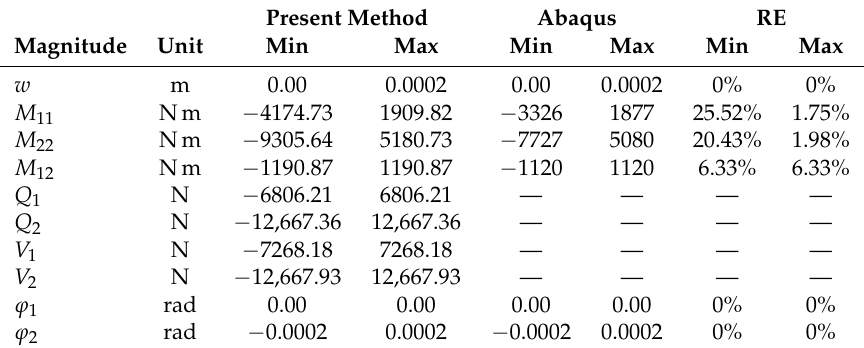
Table 5. Minimal and maximal values of magnitudes with their relational error (RE). Present